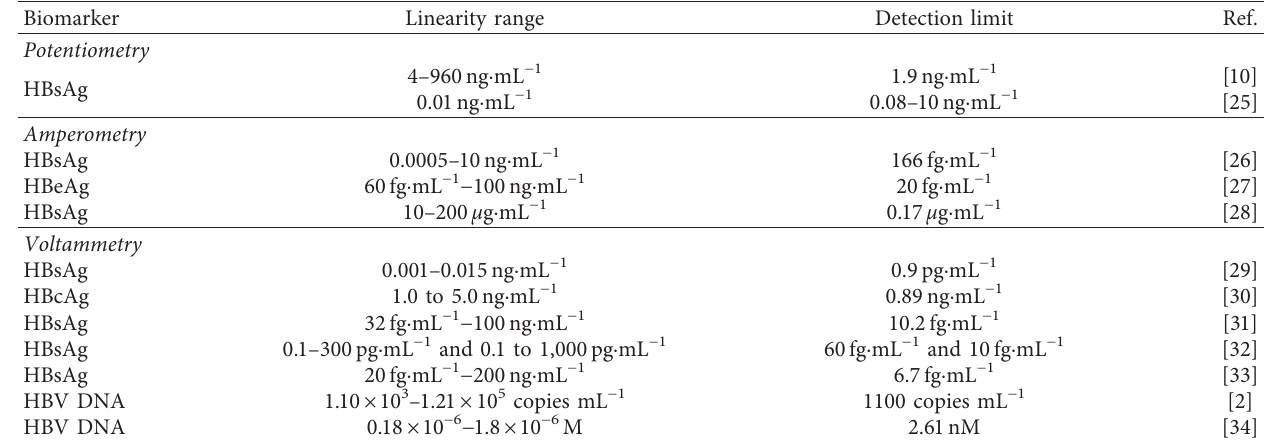
Table 4: Electrochemical detection of HBV.